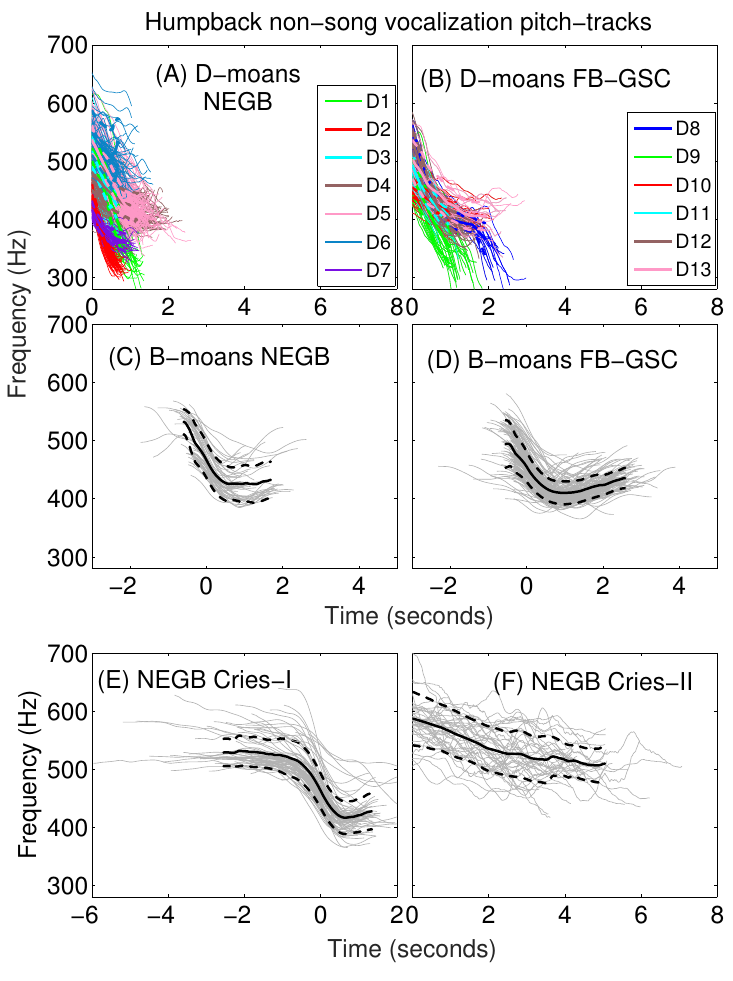
Figure 6. Ensemble of pitch-tracks extracted from received humpback vocalizations for ( A ) NEGB D-moans; ( B ) FB-GSC D-moans; ( C ) NEGB B-moans; ( D ) FB-GSC B-moans; ( E ) NEGB cries-I and ( F ) NEGB cries-II. The thick solid and dotted curves are the mean and standard deviation of each ensemble of pitch-tracks shown. The pitch-tracks for the D-moans and cries-II are aligned in time based on the start time. The pitch-tracks for the B-moans and cries-I are aligned in time based on their maximum gradients. The pitch-tracks for the D-moans are color-coded based on the clustering result for NEGB (7 sub-types) and FB-GSC (6 sub-types) (see